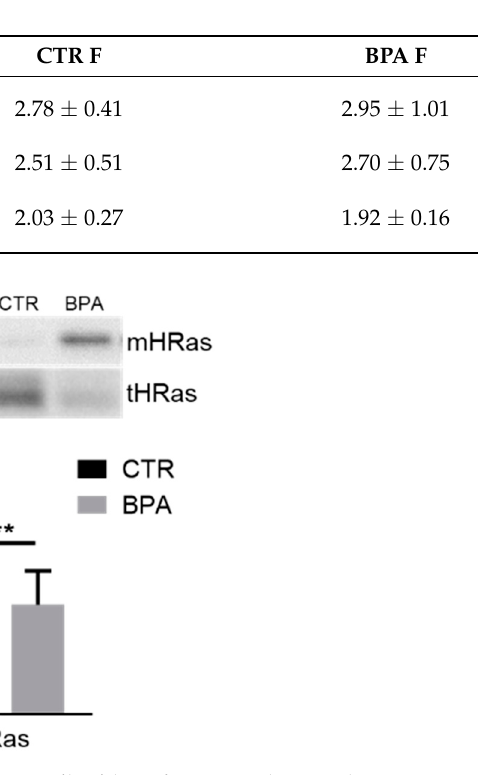
Figure 7. Effects of prenatal exposition to 2.5 µg/kg/day of BPA on inflammatory parameters in fetal livers of female rats. The figure shows typical Western blot of p-NF ĸ B p65 ( A ) and p-Stat3 ( B ) and their total levels in fetal livers from female CTR animals and the ones prenatally exposed to BPA. The graphs represent the activation state of the proteins in fetal liver lysates. ( C ) Total level of TNF- α in liver lysates of female fetuses measured by ELISA assay kit. Values are expressed as mean ± SD, n = 6 for each experimental group. Differences between groups were considered as significant at p < 0.05 and were analyzed with unpaired Student’s t test. * p < 0.5; ** p < 0.01 vs. CTR. 4. Discussion The role of BPA in several metabolic pathologies has been highlighted by many lines of evidence, although the network of action is still unsolved and represents a challenge to